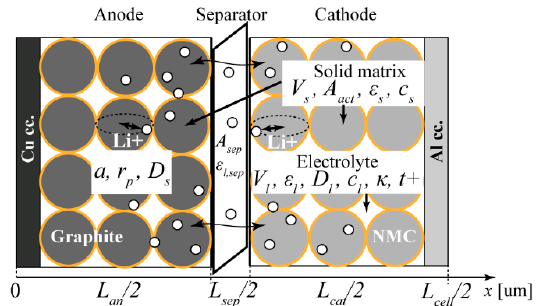
Figure 2. The characteristic NMC graphite electrode-based Li-ion cell. The specific electrochemical parameters used in the estimation have been outlined. Li transport due to migration and di ff usion only occurs along the x -axis. The cross-sectional area A sep is perpendicular to the x -axis. The electrodes and separator have double-sided